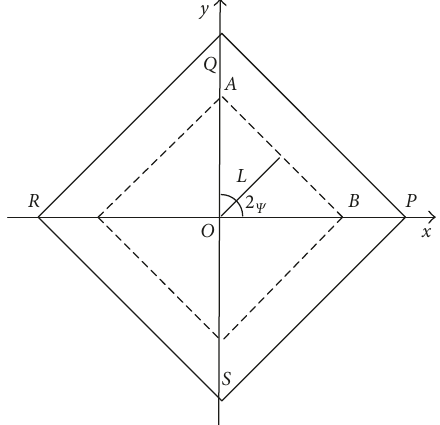
Figure 8: Petal-like cracking of the plate.